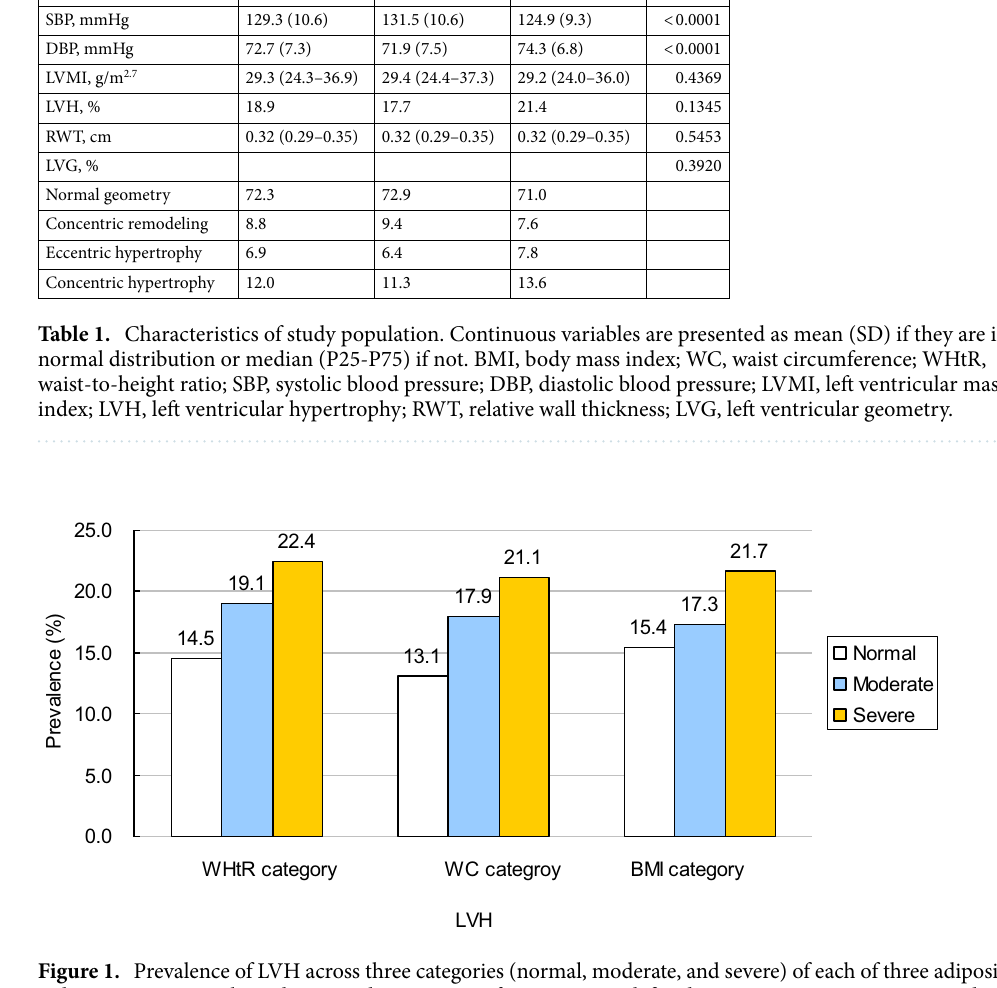
ses. The associations were more pronounced in boys than in girls for three adiposity indexes (Table S1). For LVH and eccentric hypertrophy, the associations were more pronounced in adolescents than in children; while for